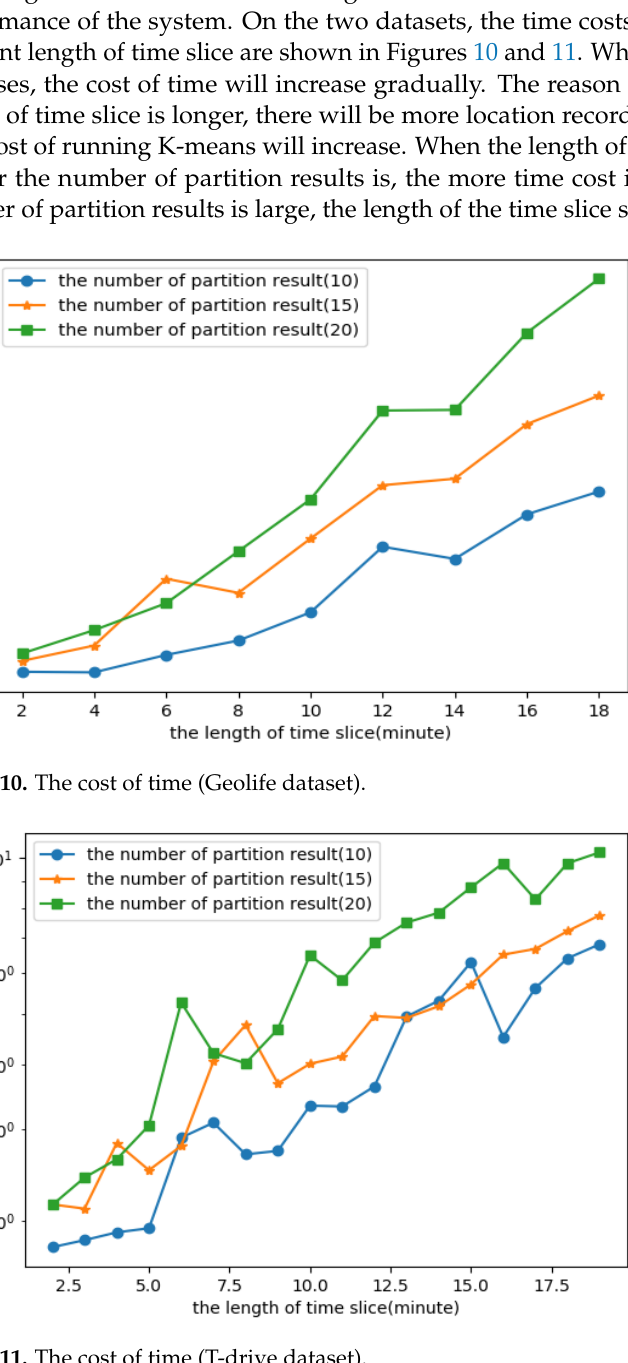
Figure 11. The cost of time (T-drive